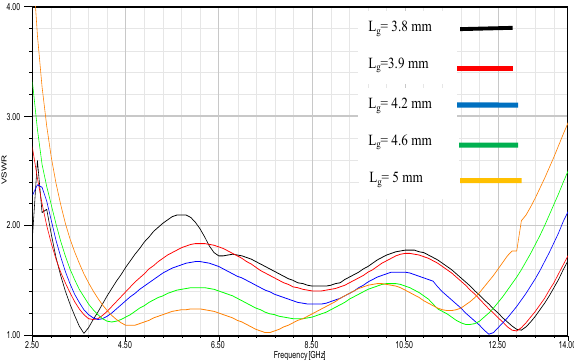
Figure 2: VSWR of the basic antenna without the slots for different values of L g .